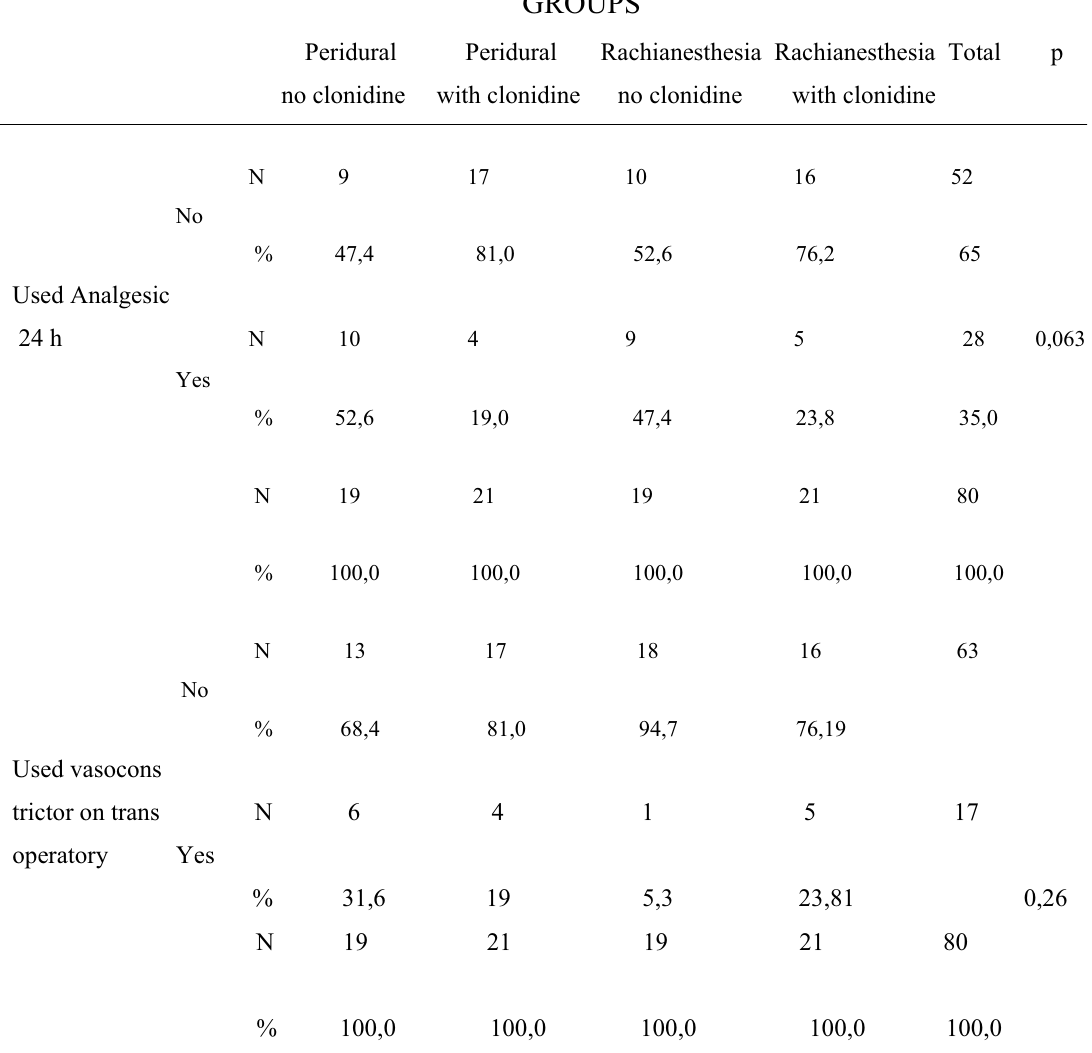
TABLE 3 - Analgesic on Post-operatory (8, 12, 24 hours) and vasoconstrictors on transoperatory, in patients undergone hemorroidectomy under peridural anesthesia and Rachianesthesia, with or without